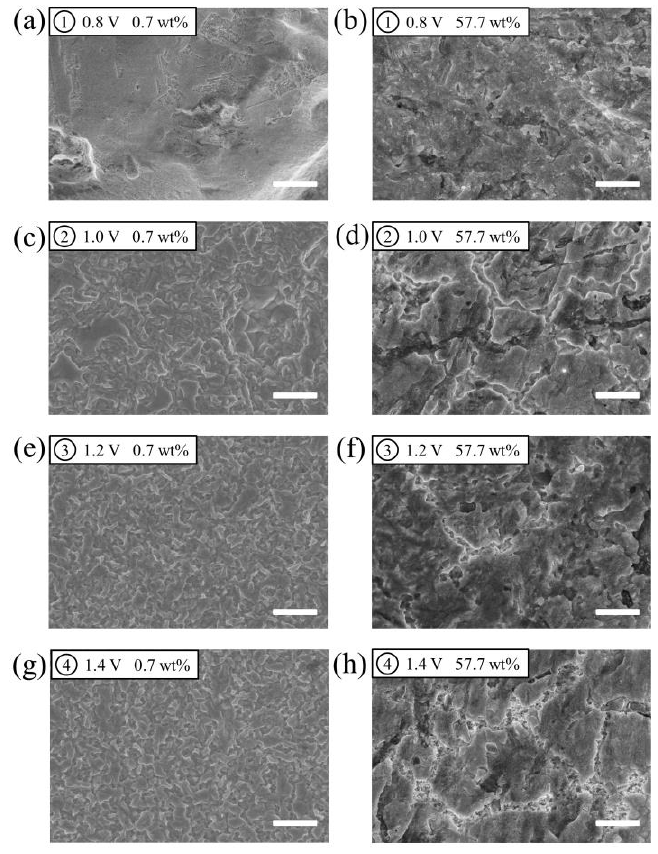
Figure 7. ( a − h ) SEM images of a gold foil after holding at different potentials for 3 min in ethaline with water contents 0.7 wt% ( a , c , e , g ) and 57.7 wt% ( b , d , f , h ). ( a , b ) 0.8 V; ( c , d ) 1.0 V; ( e , f ) 1.2 V; ( g , h ) 1.4 V. Scale bars are 2 μm.